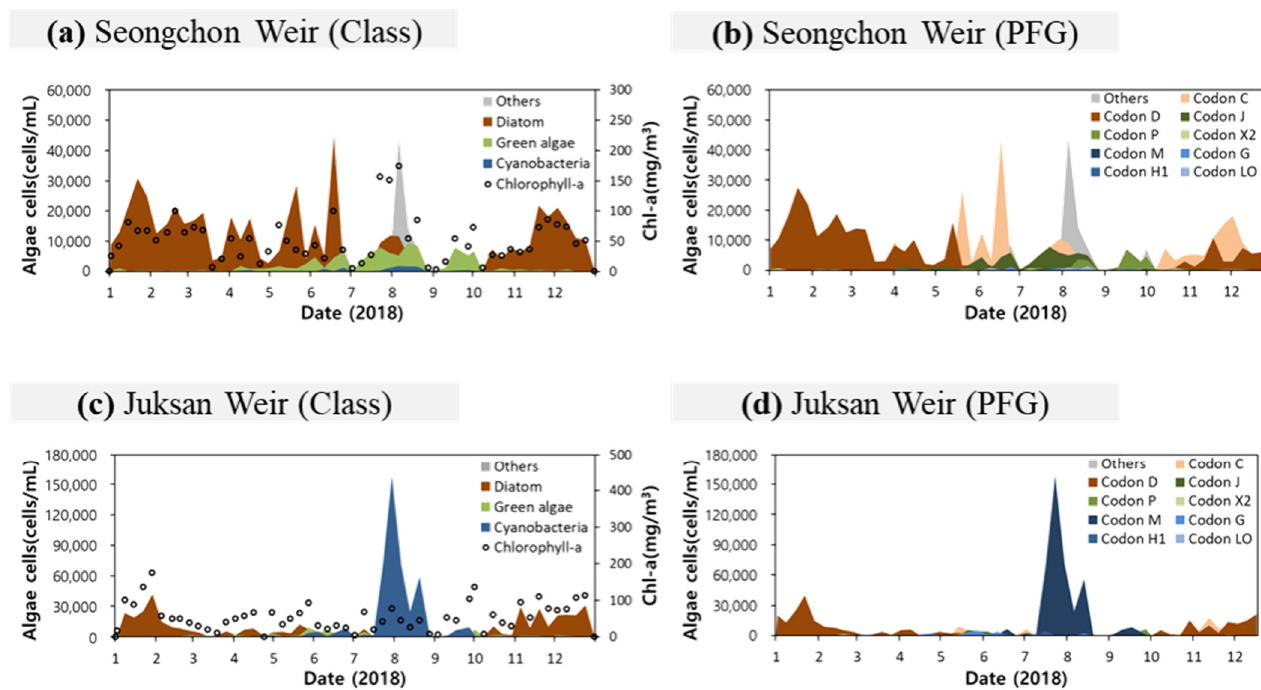
Figure 4. Chlorophyll a concentration and algal cells at the Seungchon Weir by ( a ) class and ( b ) phytoplankton functional group (PFG) and at the Juksan Weir by ( c ) class and ( d ) PFG for 2018. The average water qualities from the headwater to the estuary of the Yeongsan River are shown in Table 5. Table 5. Water qualities from the headwater to the estuary (2014–2018) monitoring stations.